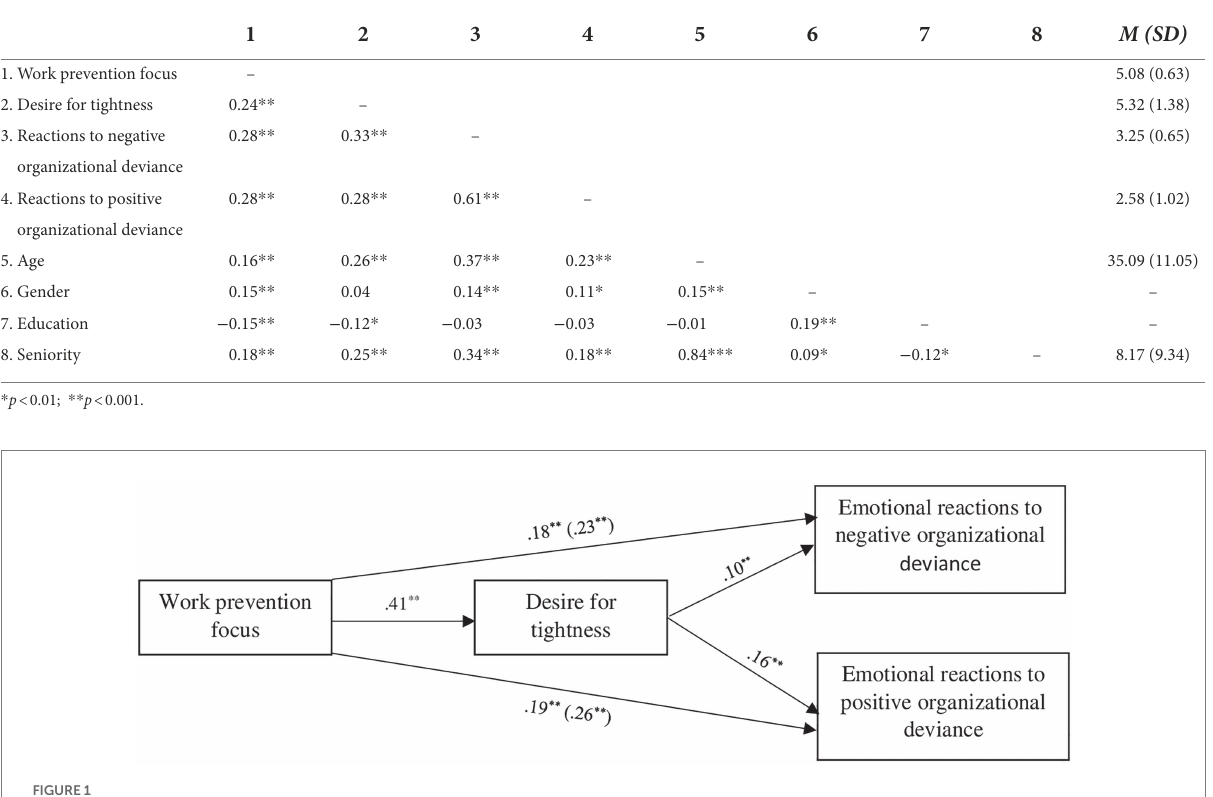
FIGURE 1 Effect of work prevention focus on reactions toward negative and positive organizational deviance via desire for tightness. N = 788 All coefficients are unstandardized. The total effect is inside the parentheses * p < 0.01, ** p < 0.001. High s of reaction toward organizational deviance reflects higher disapproval (i.e., anger,